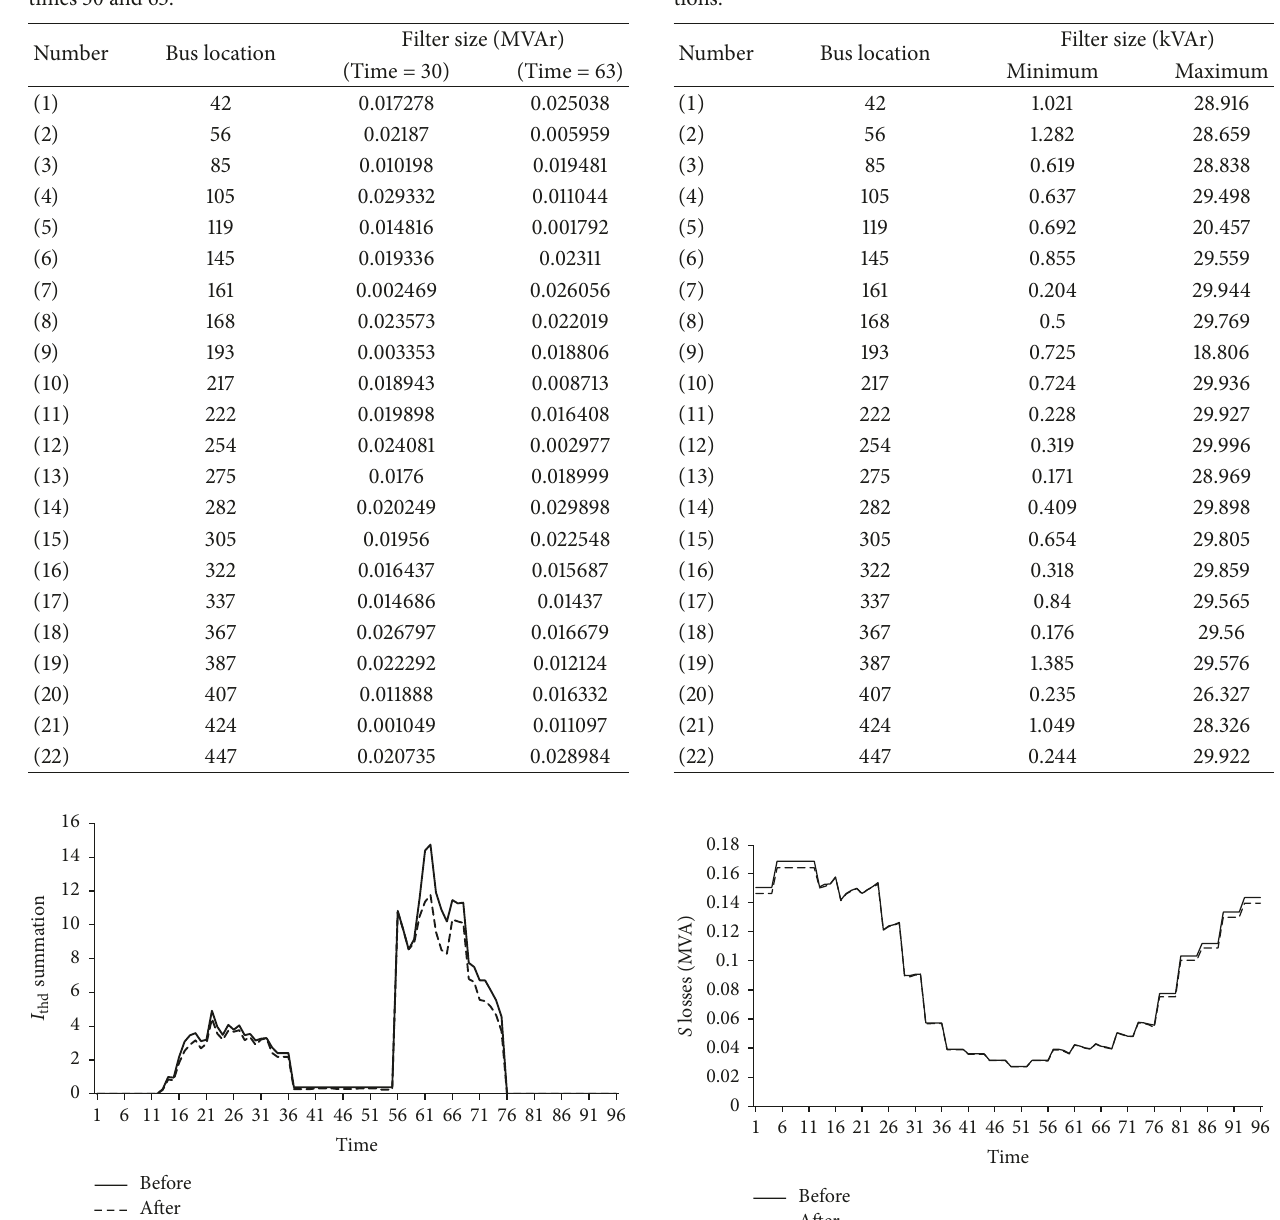
Table 8: Filter size based on the best solution after fuzzy at sampling times 30 and 63.